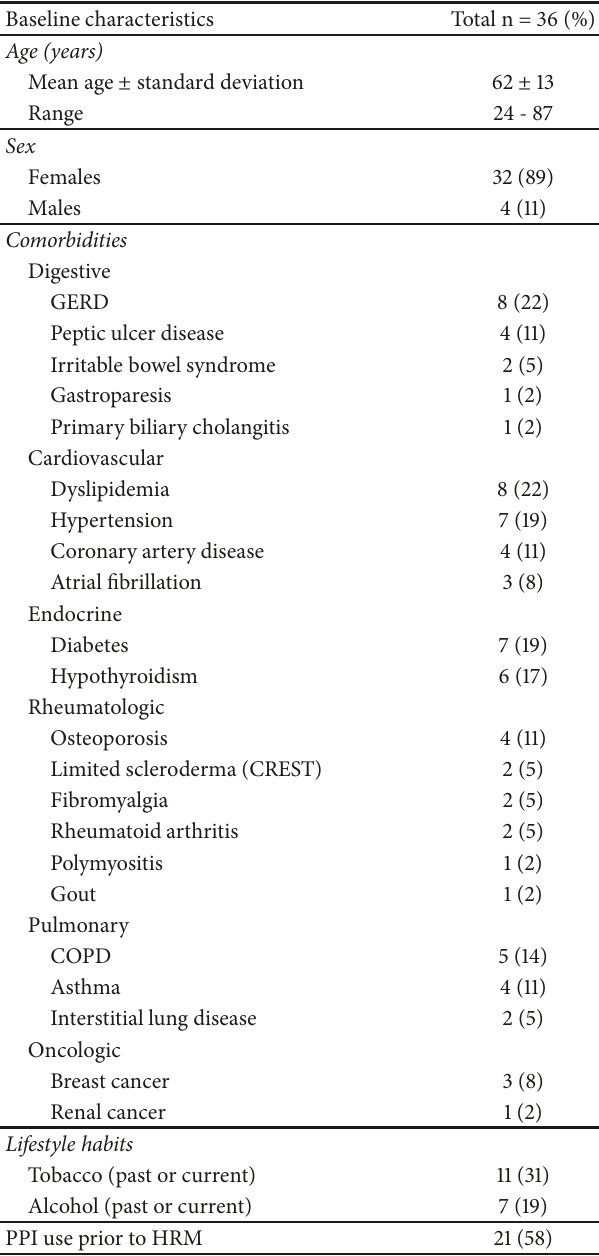
Table 1: Demographic characteristics and comorbidities of patients with Jackhammer esophagus.